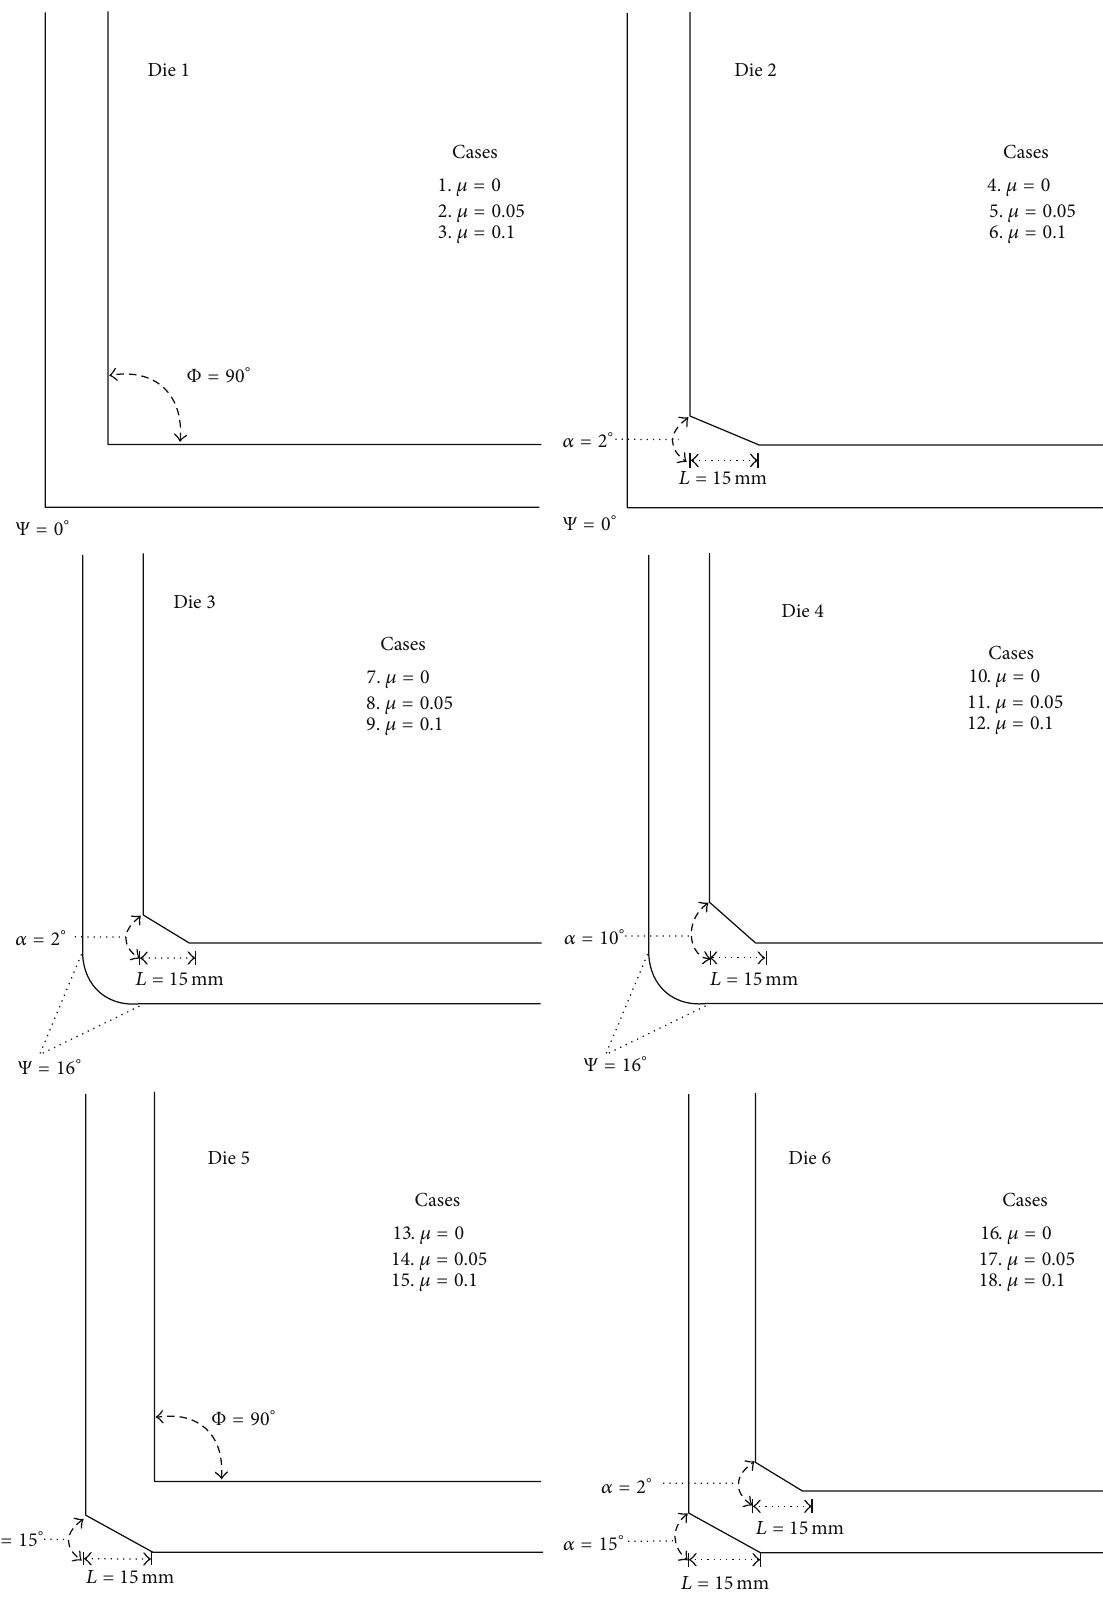
Figure 2: ECAP die’s channel geometry and dimensions of the six configurations used in the